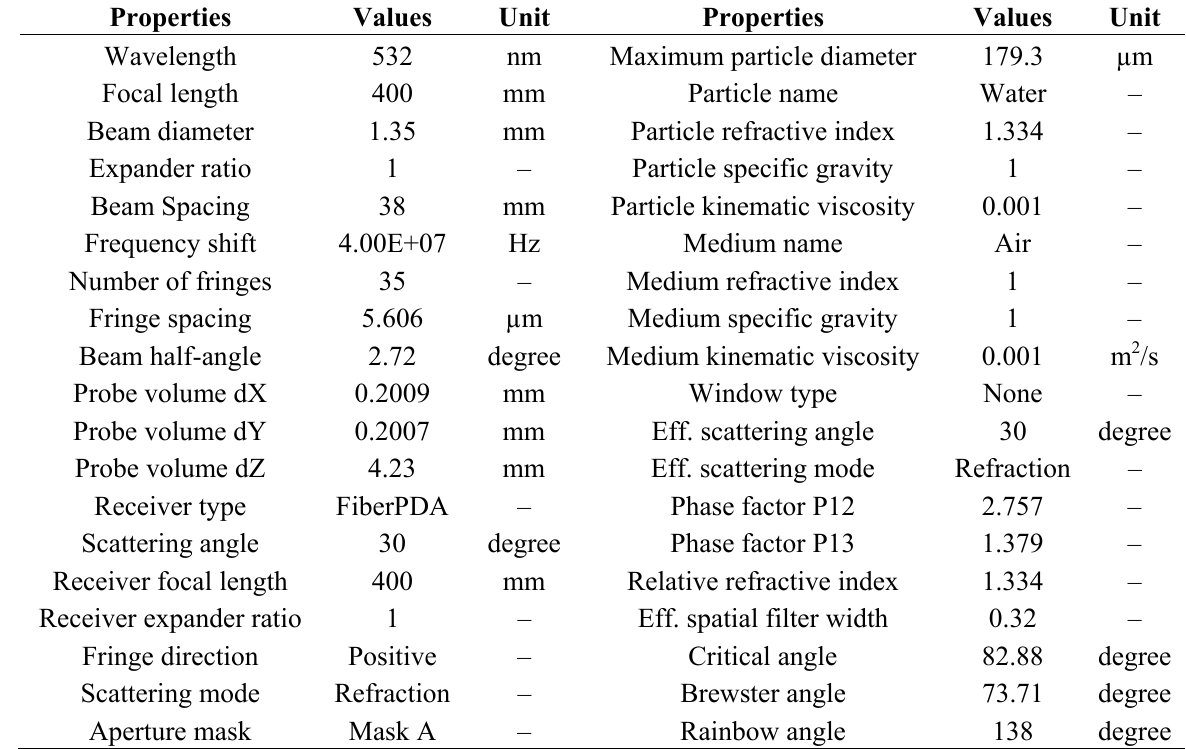
Table A1. Configuration of properties in PDA.